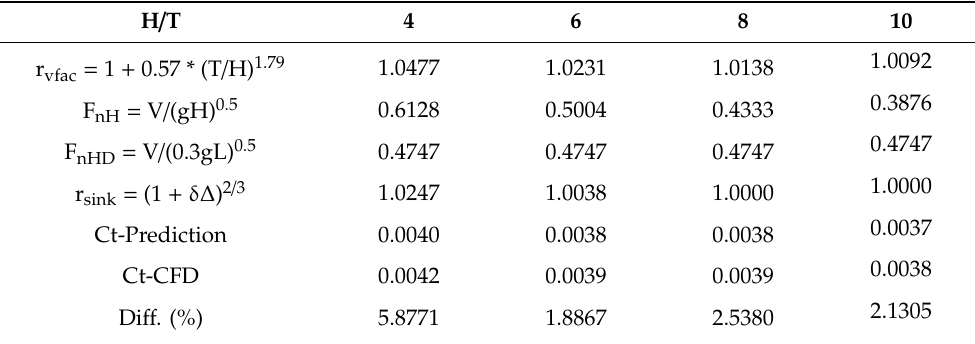
Table 16. The di ff erence of total resistance coe ffi cients between Raven’s method and CFD results. H / T 4 6 8 10 Table 16. The difference of total resistance coefficients between Raven’s method and CFD results. r vfac = 1 + 0.57 * (T / H) 1.79 1.0477 1.0231 1.0138 F nH = V / (gH) 0.5 F nHD = V / (0.3gL) 0.5